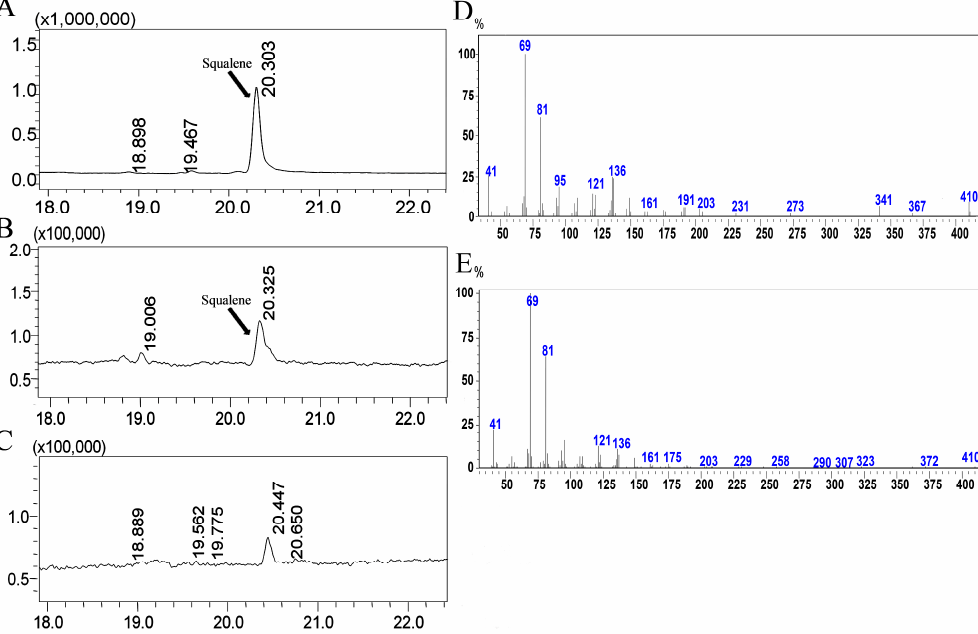
Figure 4. GC–MS analysis of squalene in the catalytic products of TwSQS. ( A ) GC detection of the standard squalene; ( B ) GC detection of the reaction products of TwSQS; ( C ) Control (crude protein of the control strain); ( D ) The mass spectrum of standard squalene; ( E ) MS analysis of the catalytic products of TwSQS.